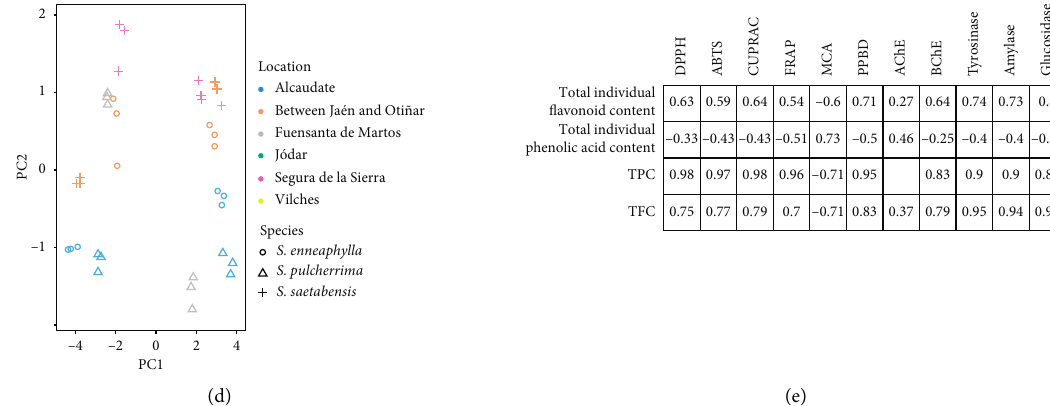
Figure 3: Principal component analysis of Sarcocapnos species based on biological activities profiling. (a) Percentage of variance explained by each principal component. (b) Relation between biological activities and the principal component. (c, d) Score plot representing samples in the space PC1 vs PC2 in terms of extractive solvent and geographical origins, respectively. (e) Correlation between phenolic/flavonoid contents and biological activities.